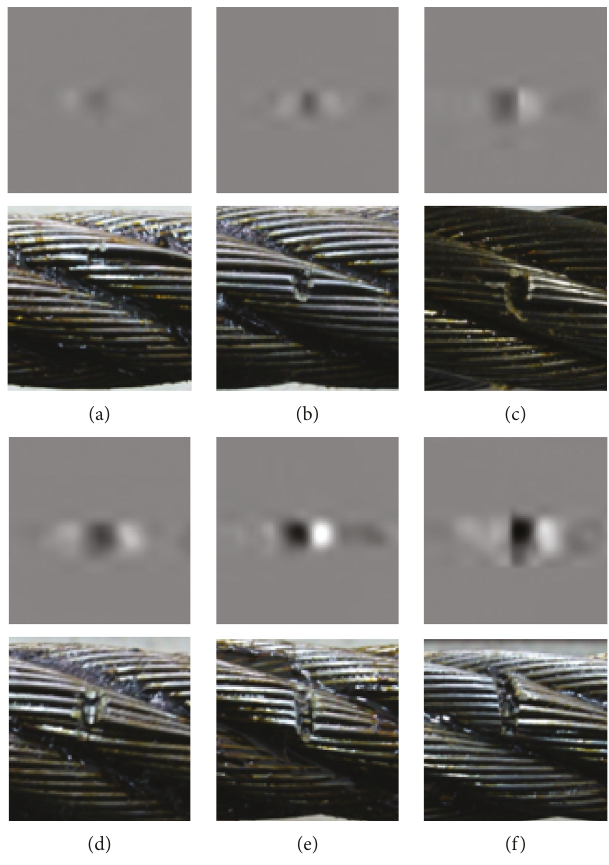
Figure 12: Grayscale images (top) and photos (bottom) of 6 different defects. (a) One broken wire, (b) two broken wires, (c) three broken wires, (d) four broken wires, (e) five broken wires, and (f) seven broken wires.